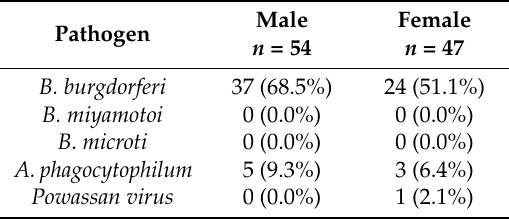
Table 3. I. scapularis submissions by sex submitted through active tick surveillance in the NWHU catchment area from 2017 *.